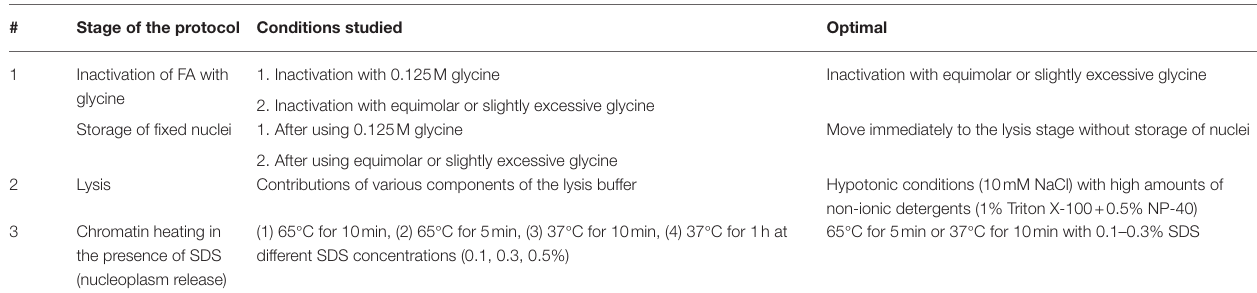
TABLE 4 | Conditions found to be optimal for stages of the 3 С protocol. Stage of the protocol Conditions studied